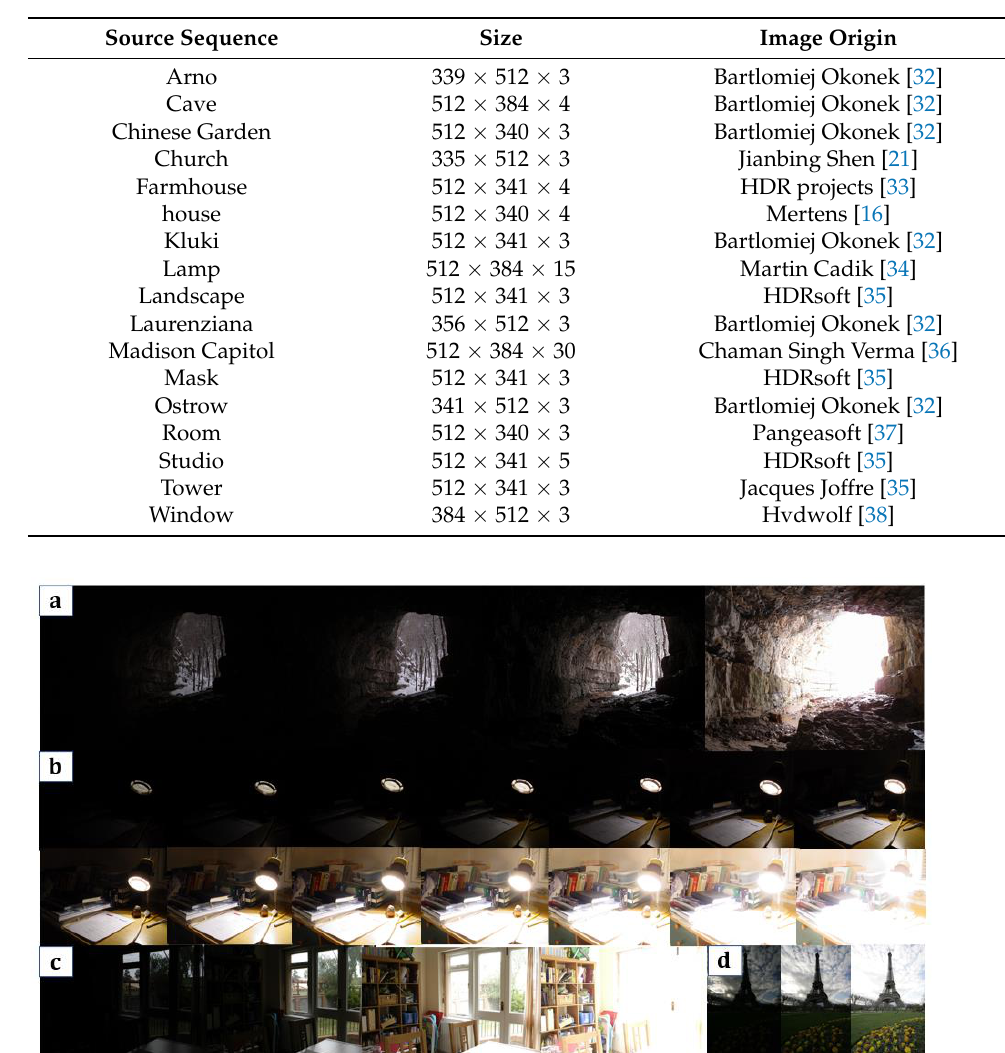
Table 2. Information about the static source sequences.